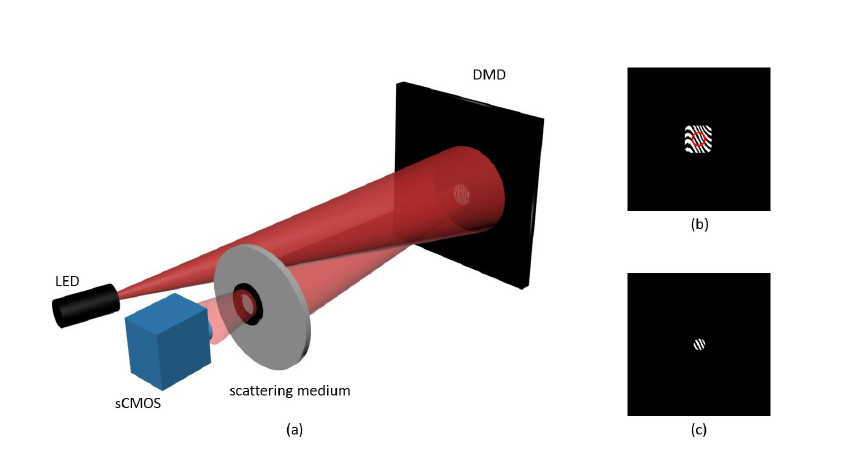
Figure 2. Experimental setup. ( a ) Experiment setup, ( b ) the target, and ( c ) an example of the probed beam as marked in red circle in ( b ).